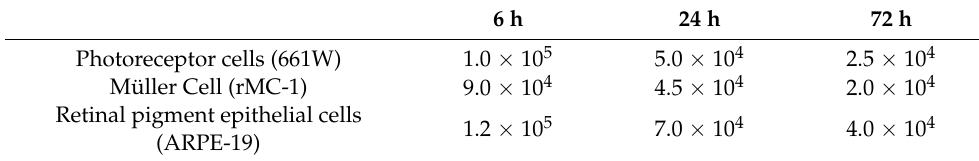
Table 1. The optimised seeding density (number of cells) of three retinal cell